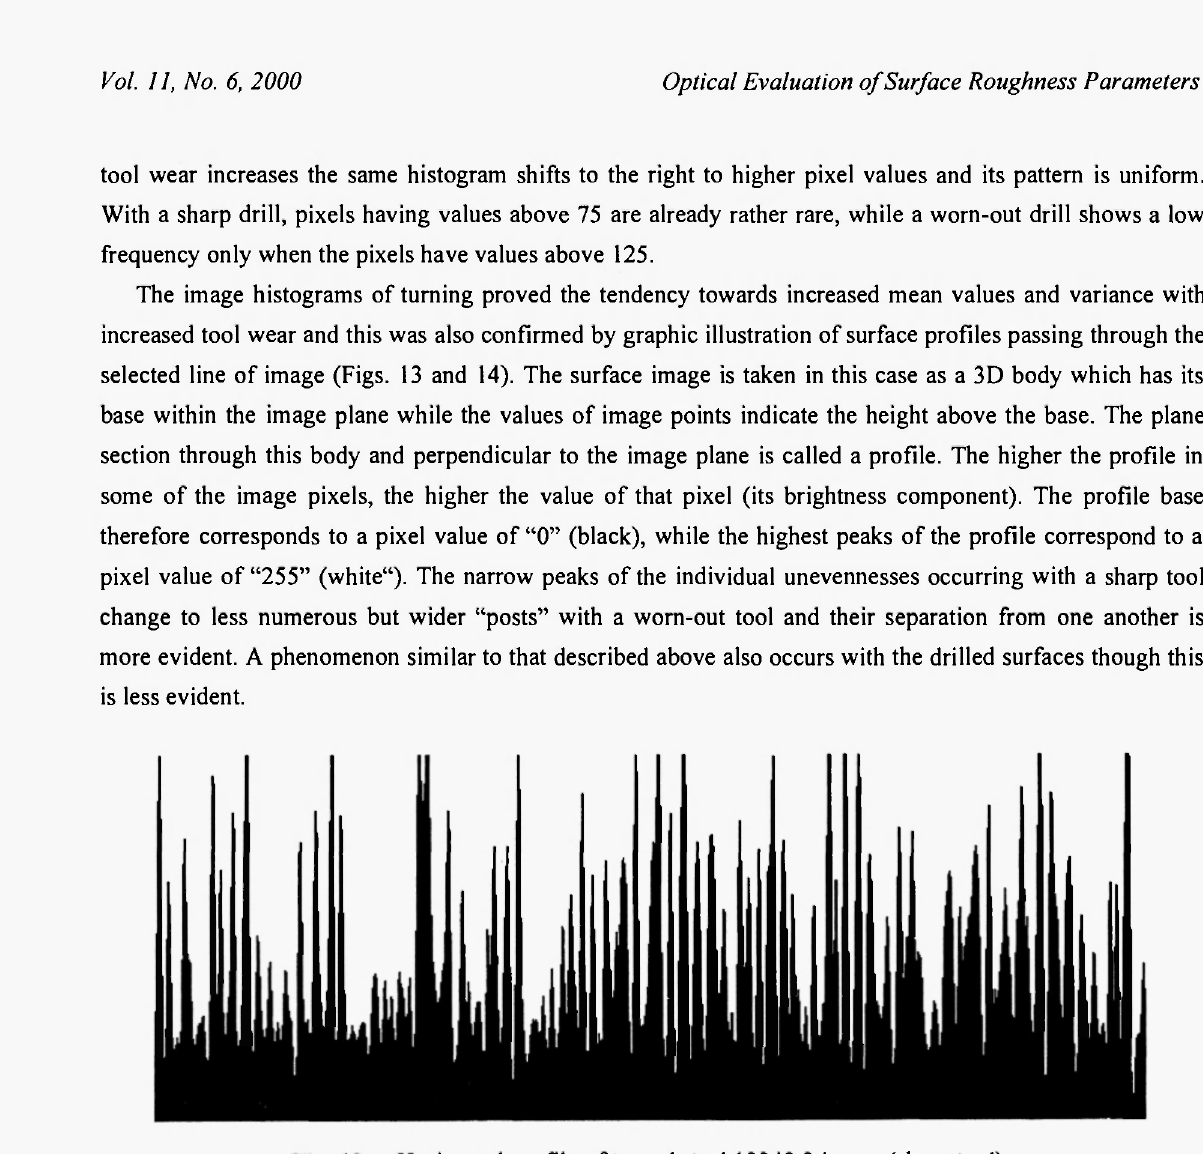
Fig. 13: Horizontal profile of turned steel 13240.3 image (sharp tool).